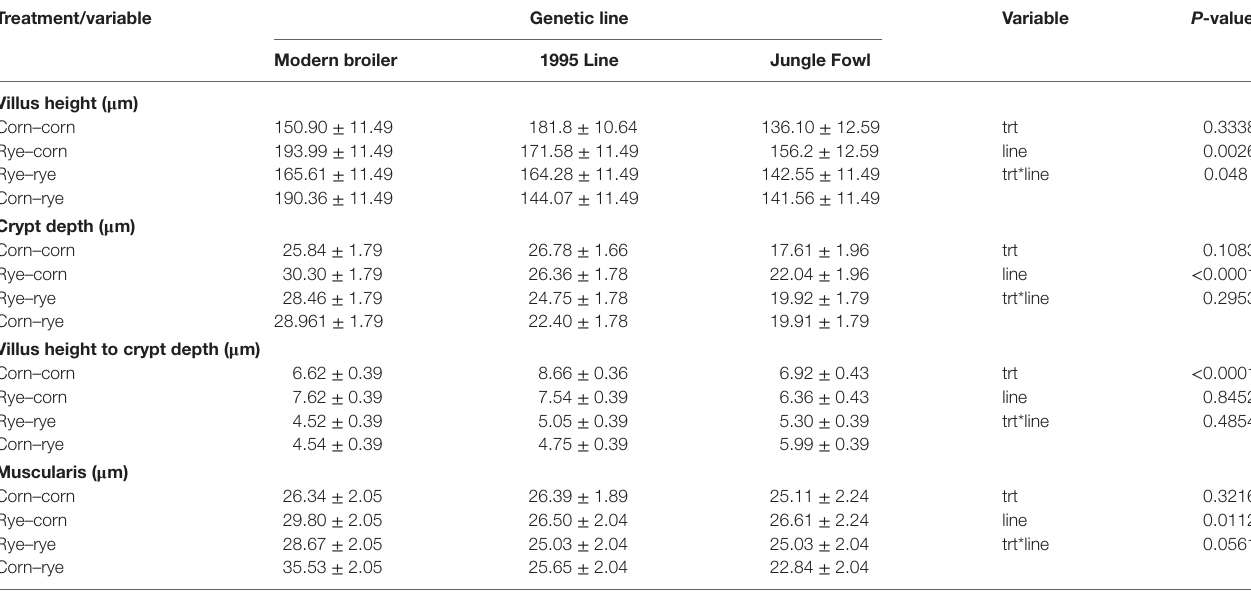
TaBle 6 | Evaluation of a nutritional rehabilitation model on morphometric analysis of ileum in three genetic chicken lines fed rye or corn at varying time points at day 20 of age.